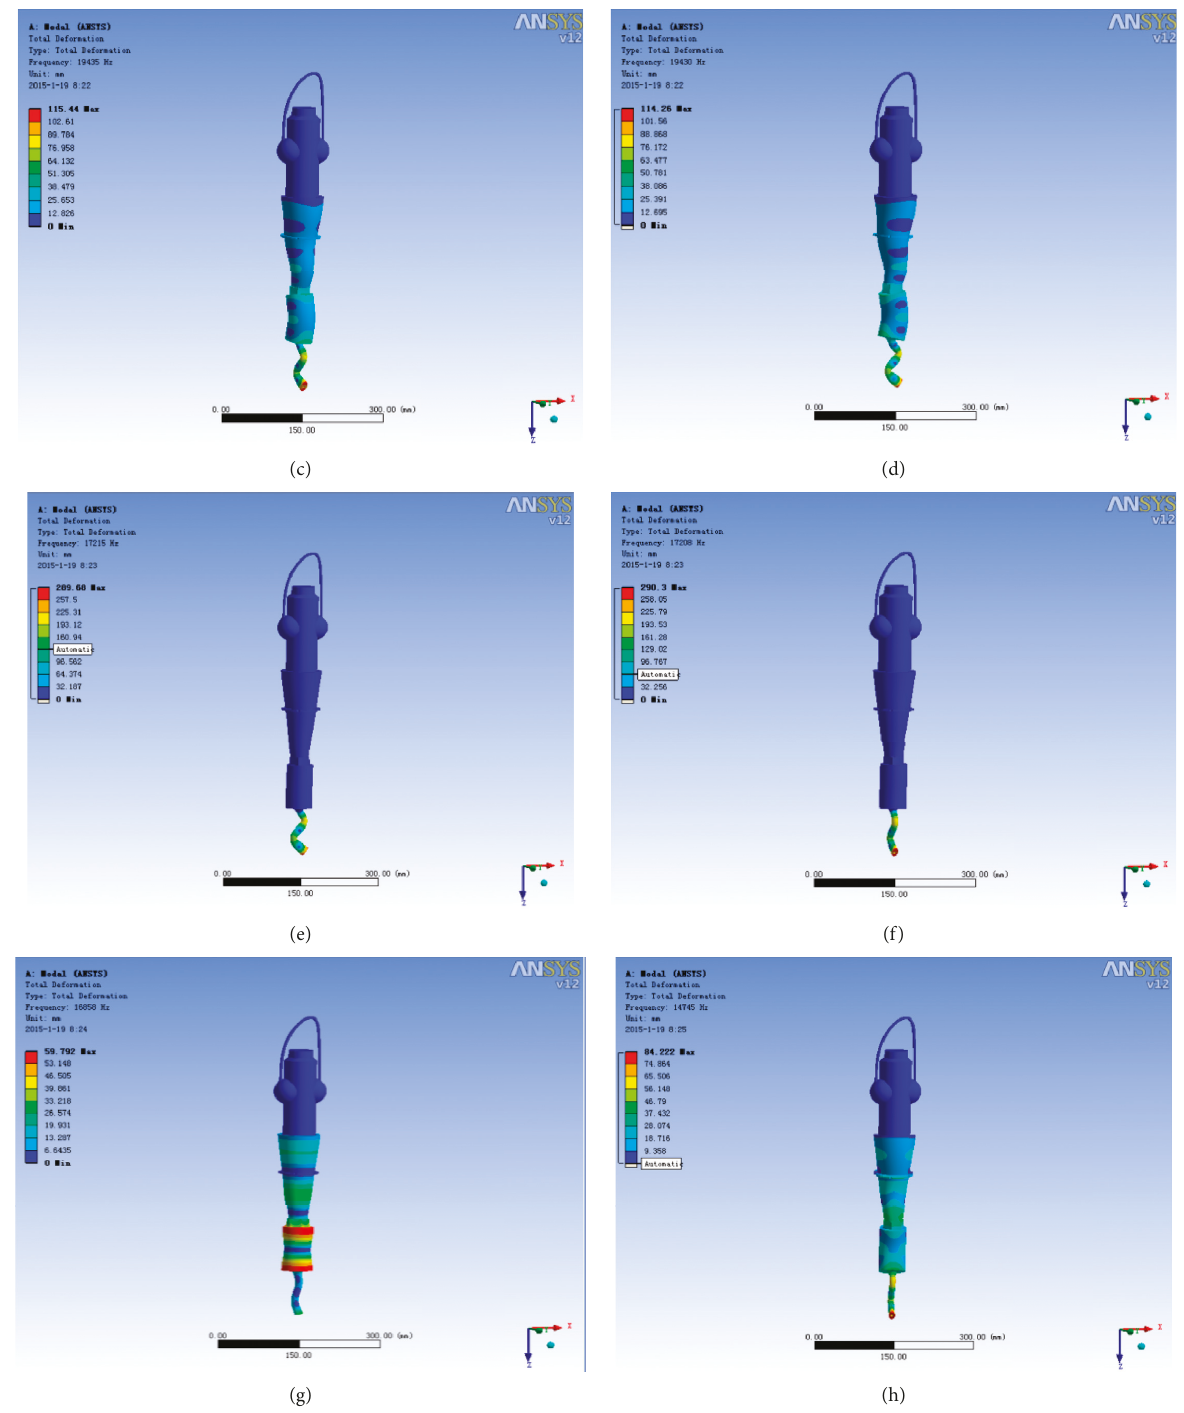
Figure 6: The nozzle model of ultrasonic waterjet. (a) Frequency of 21569 (vertical). (b) Frequency of 20908 (axial). (c) Frequency of 19435. (d) Frequency of 19430. (e) Frequency of 17215. (f) Frequency of 17208. (g) Frequency of 16858. (h) Frequency of